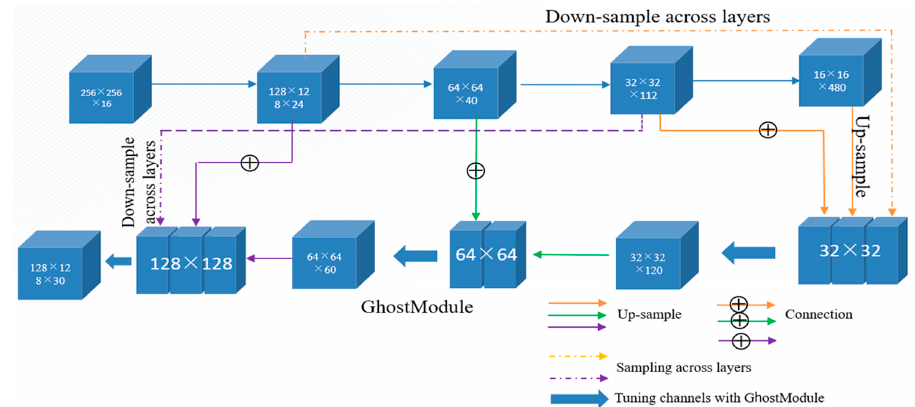
Figure 3. Lightweight multiscale fusion structure.